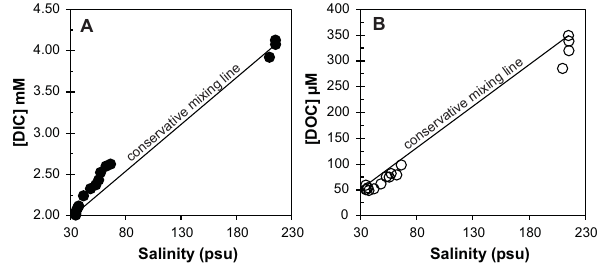
Fig. 2. Mixing diagrams for (A) DIC and (B) DOC concentrations across the seawater–brine interface plotted along with solid lines which represent expected concentrations from conservative mixing of brine and seawater